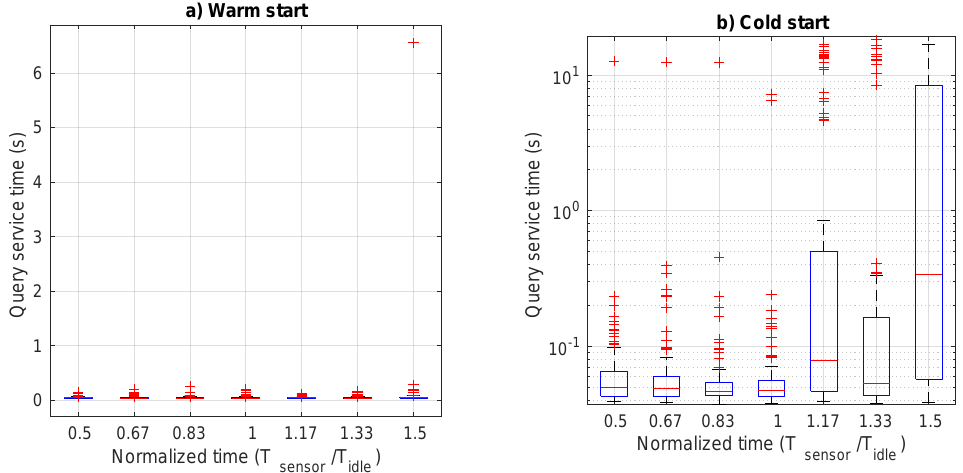
Figure 11. Boxplot of query service time as a function of the normalized transmission period: ( a ) warm start and ( b ) cold